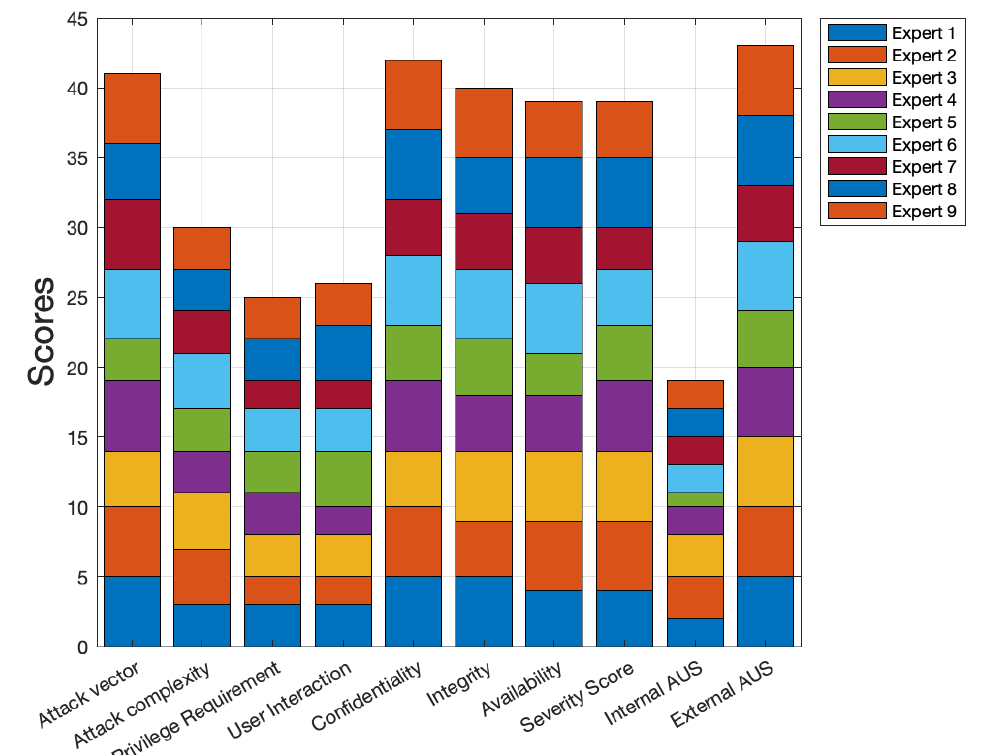
Figure 4. Ranking of the criteria by security